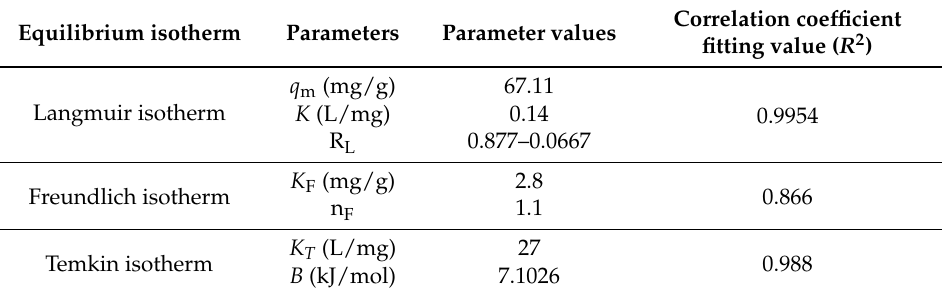
Figure 5. Langmuir adsorption isotherm for BV 14 dye adsorption onto the chemically modified nanofibers. Table 1. Estimated equilibrium parameters for the studied equilibrium isotherms of the dye adsorption process onto the chemically modified nanofiber.